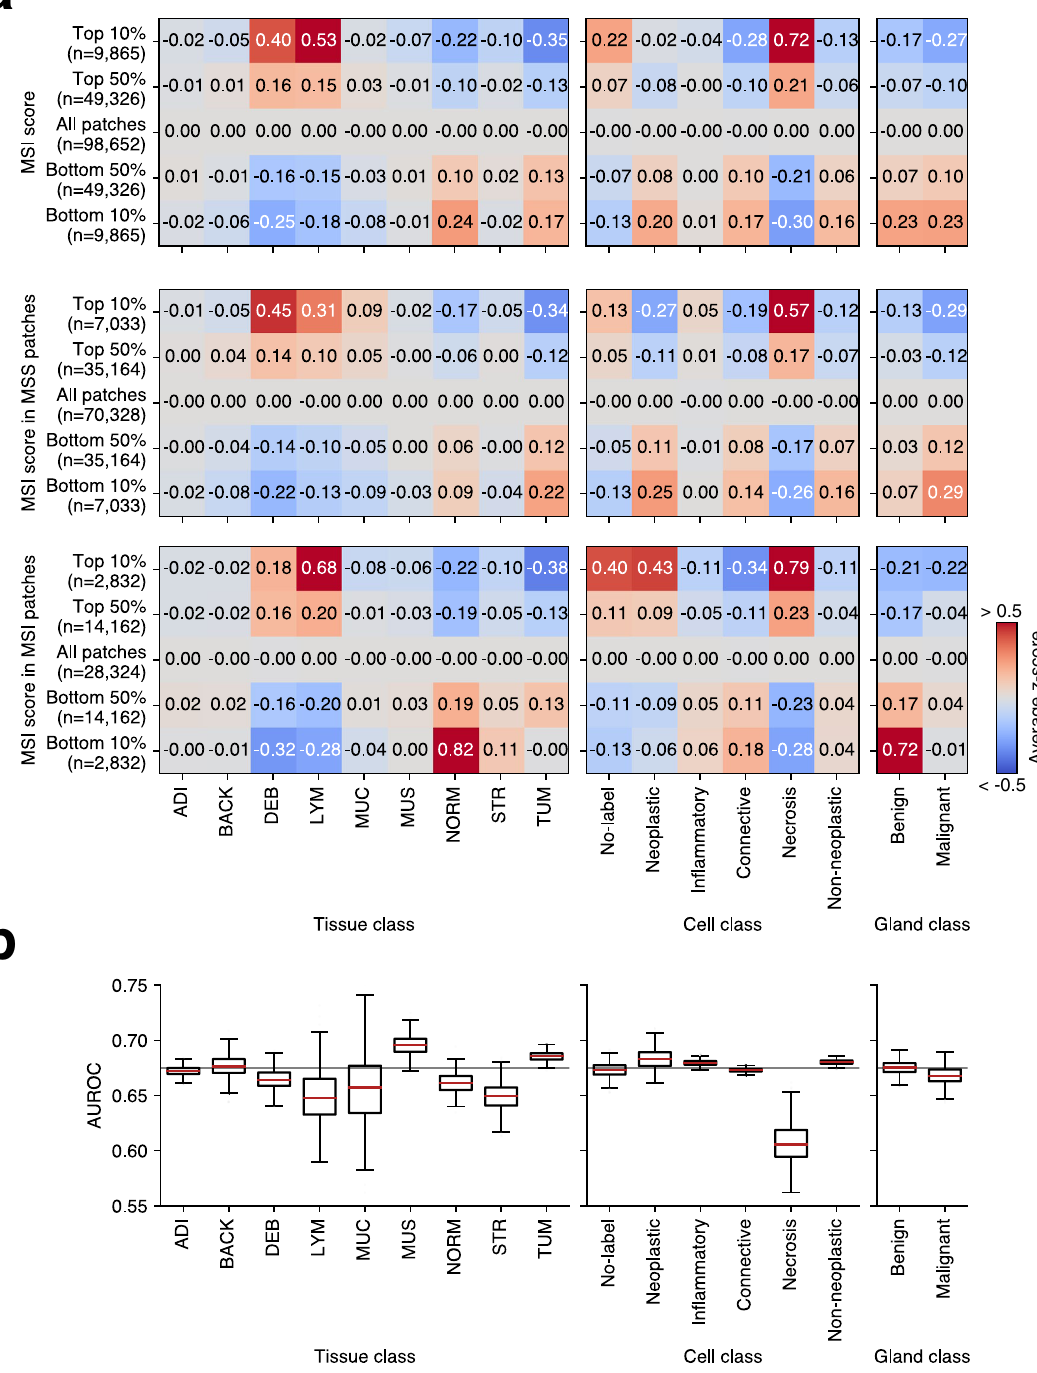
Figure 2. Image features extracted by high- and low-level approaches. ( a ) For the high-level approach, average z scores for tissue, cell, and gland features were displayed as a heatmap by dividing patches into five groups (top 10, 50%, all patches and bottom 10, 50%) based on the MSI score. The values are calculated in all patches (top), and in MSS patches (middle), in MSI patches (bottom). ( b ) For the low-level approach, the values of the areas under the receiver operating characteristic curve (AUROCs) corresponding to each feature calculated from the permutation test are shown as boxplots. The gray line indicates the original performance (0.6749) of the model. ADI adipose tissue, BACK background, DEB debris, LYM lymphocytes, MUC mucus, MUS smooth muscle, NORM normal colon mucosa, STR cancer-associated stroma, TUM colorectal adenocarcinoma epithelium. The heatmaps were created with Python v3.8.8 (https:// www. python. org) and Matplotlib v3.4.3 (https:// www. matpl otlib. org). The figure was generated using Inkscape v1.1 (https:// inksc ape.